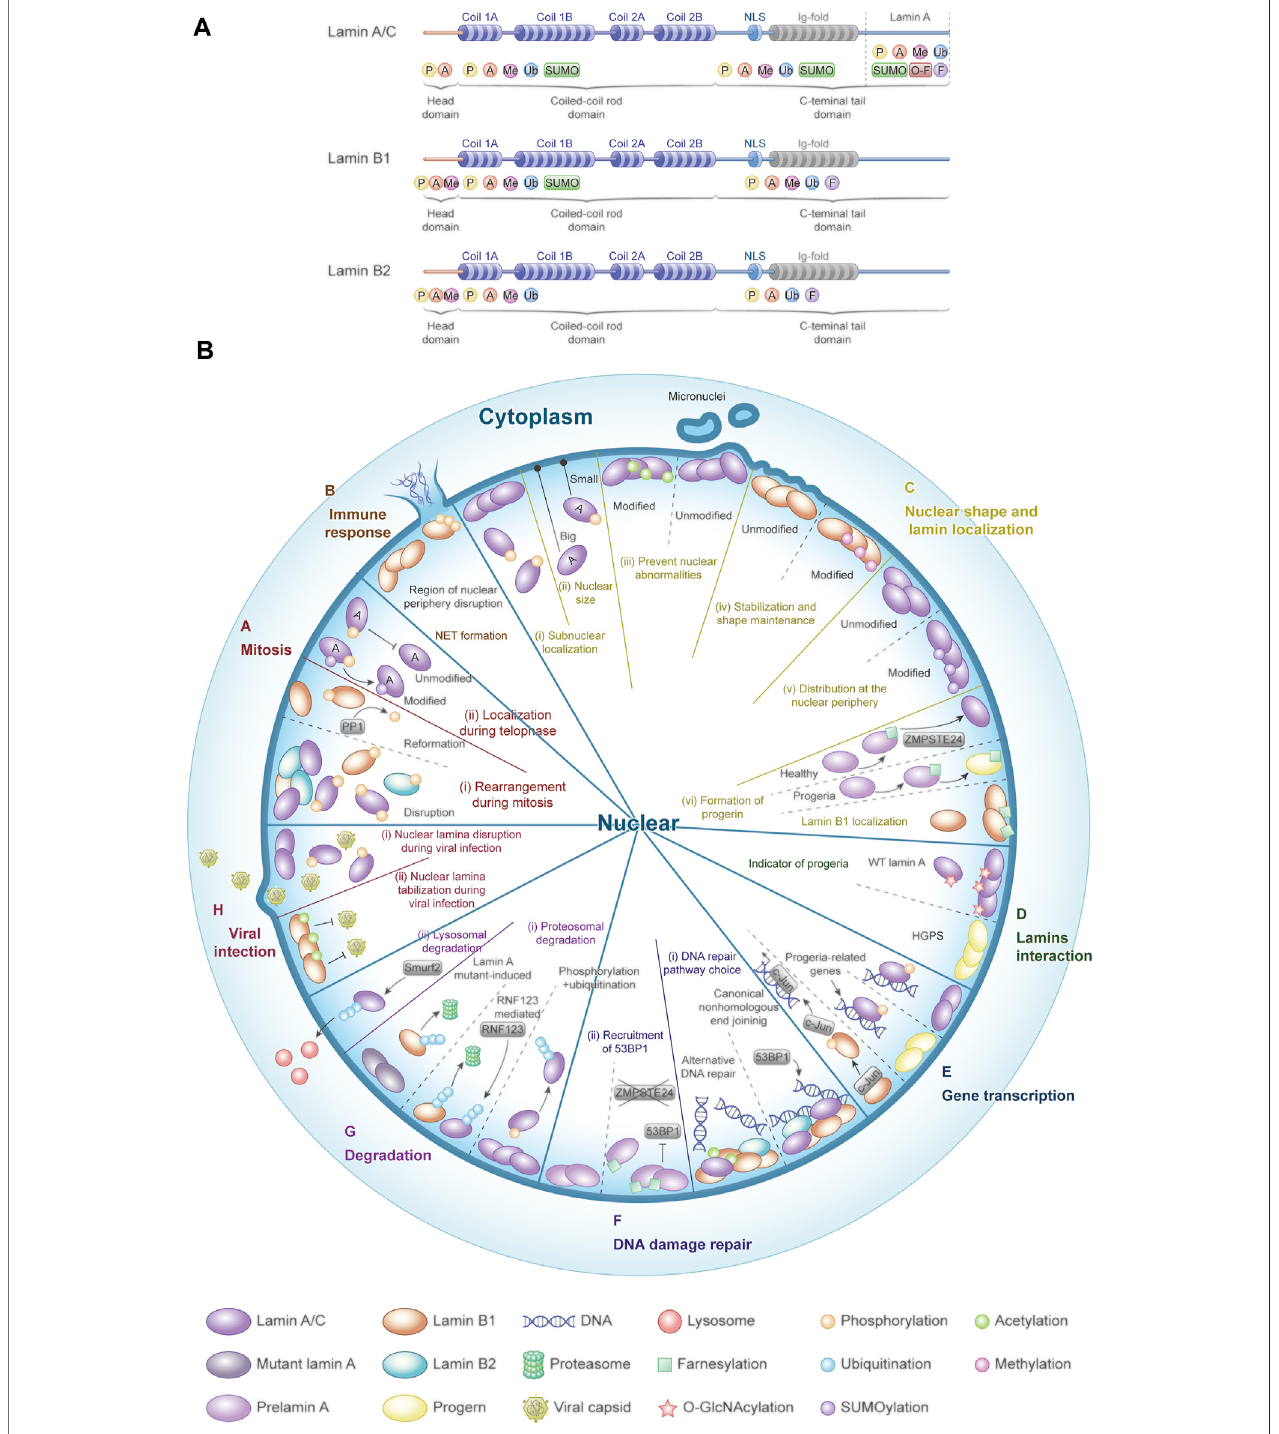
FIGURE3| Post-translationalmodi fi cationsoflaminsandtheirmultifunctionalroles. (A) LaminsundergovariousPTMsindifferentdomains. (B) Landscapeofpost- translational modi fi cations and functions. PTMs of lamins are involved in mitosis, viral infection and immune response, nuclear shape and lamin localization, lamin interaction, gene transcription, and DNA damage repair, as well as lamin degradation (modi fi ed from Murray-Nerger et al., 2021).